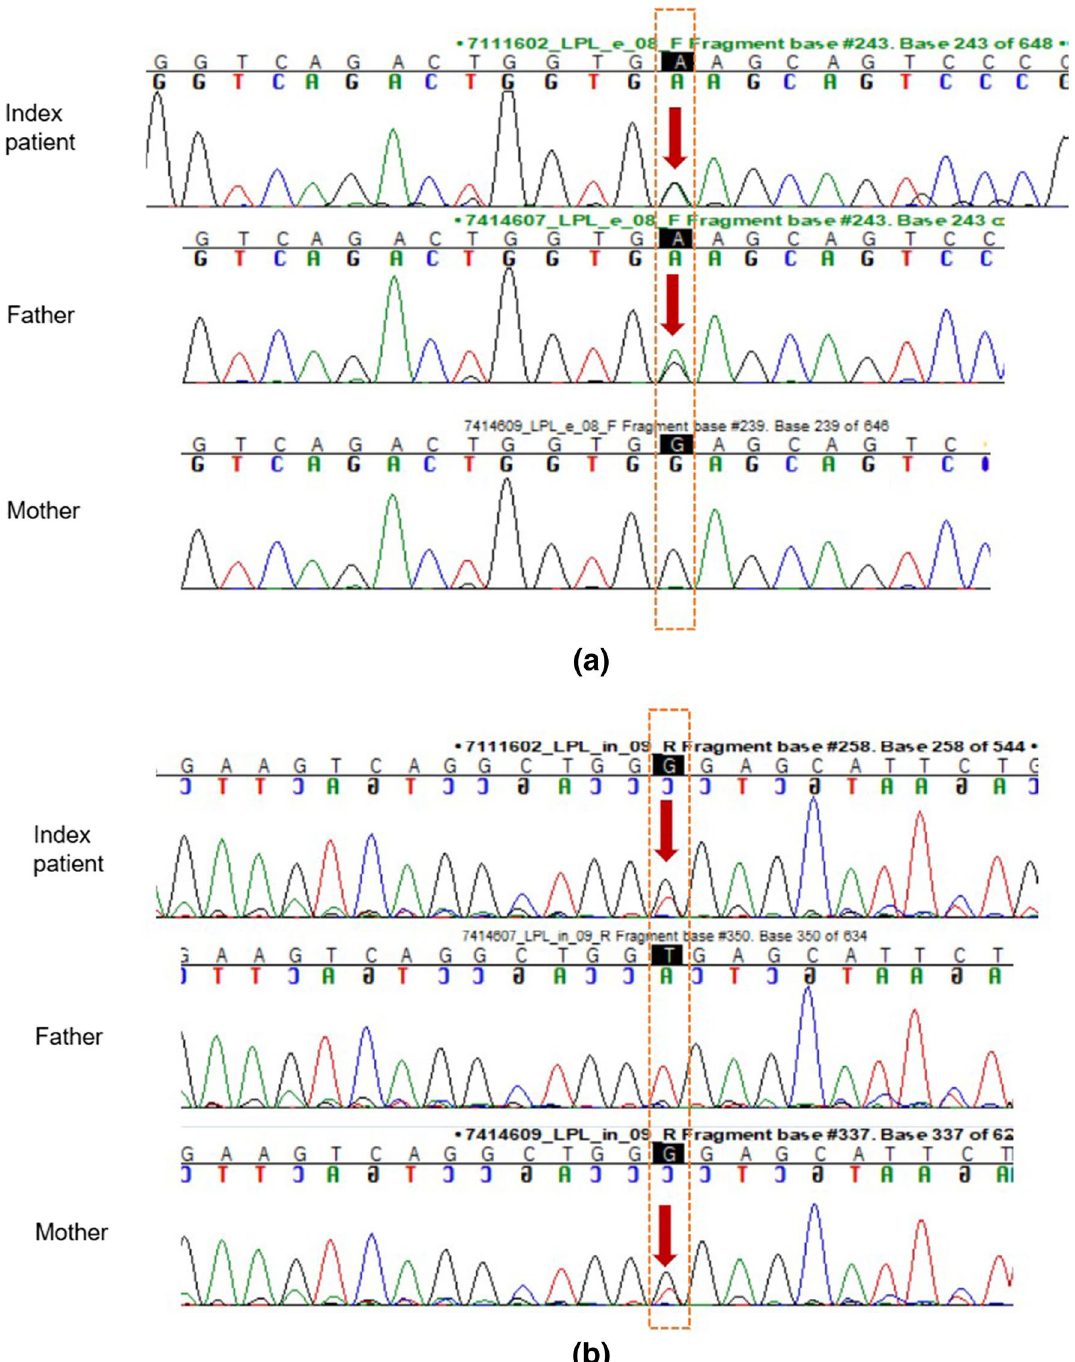
Fig. 6 Sanger Sequencing Chromatograms. Partial DNA sequences in the LPL gene by Sanger sequencing of Index patient and his parents a exon 8 b intron 9 of the LPL